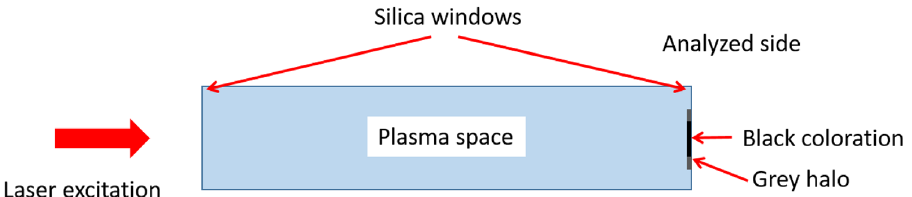
Figure 1. Sketch of the Rubidium cell. The direction of excitation in the homogenous plasma experiments and the cleaning laser pulses are the same. The coloration was observed on the inner side of the opposing